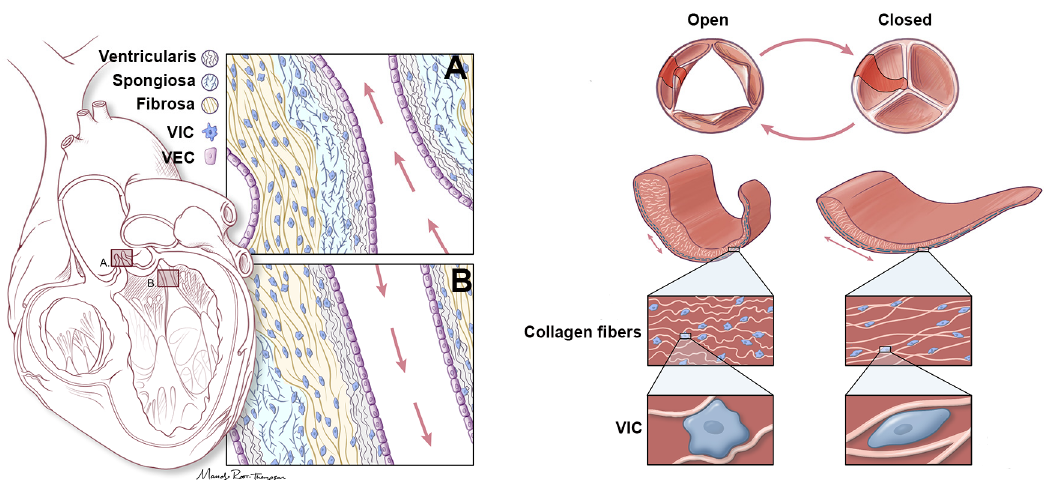
Figure 1. Representation of aortic and mitral valve structure. (Left) Aortic ( A ) and Mitral ( B ) valve structures to show organization of three ECM layers, including the ventricularis (elastin), spongiosa (PGs-GAGs) and fibrosa (collagens). Each layer is arranged according to blood flow as indicated by red arrows (ventricularis / atrialis closest to blood flow). Overlying the valve leaflets (mitral) or cusps (aortic) is a single layer of valve endothelial cells (VECs, purple), while a population of valve interstitial cells (VICs, blue) are embedded within the core. (Right) Representation of the aortic valve indicating coordinated rearrangement of the ECM fibers, and elongation of the VICs during systole (open) and diastole (closed).